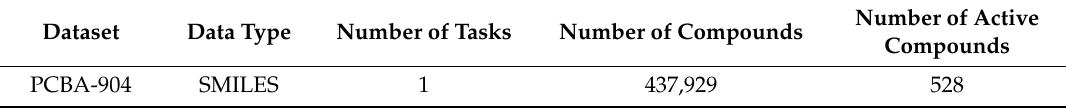
Table 2. Target data